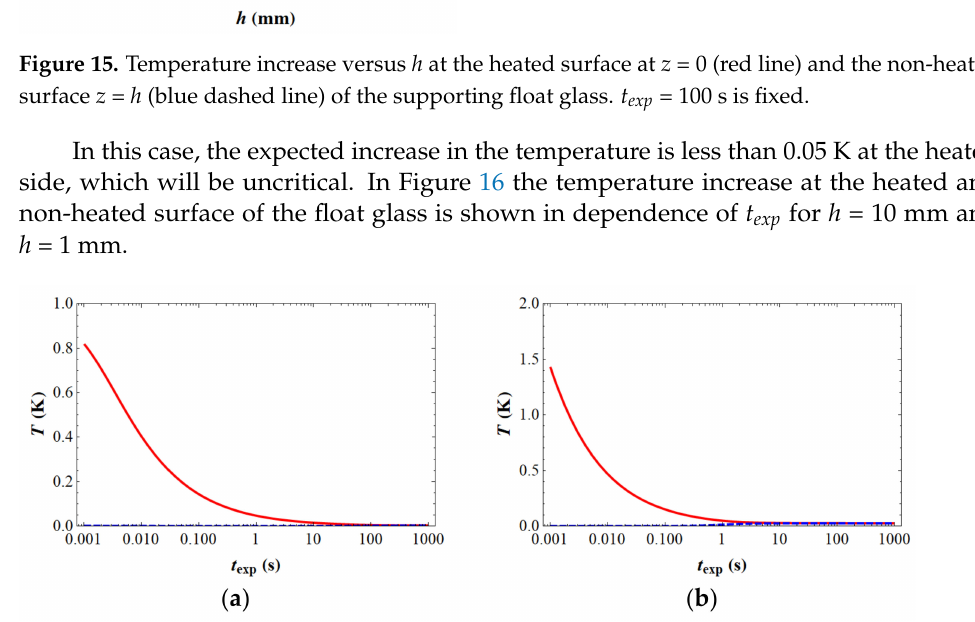
Figure 16. Temperature increase T versus t exp at the heated surface at z = 0 (red line) and the non-heated surface z = h (blue dashed line) of the supporting float glass. h = 10 mm ( a ) and h = 1 mm ( b